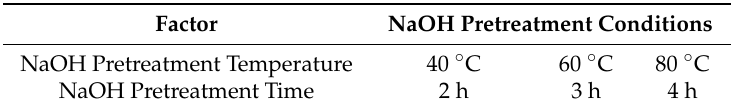
Table 1. Level of NaOH pretreatment